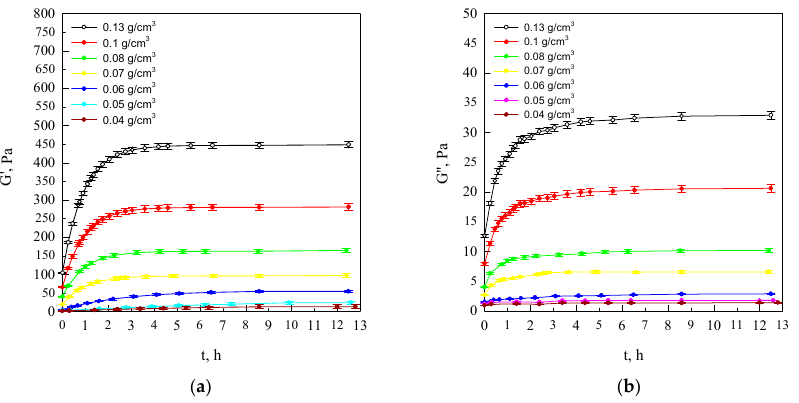
Figure 1. Kinetics of storage modulus ( G ′ ) ( a ) and of the loss modulus ( G ″ ) ( b ) in the process of formation of starch gels at different concentrations of starch in systems. The values are expressed as means ± SD ( n = 3).